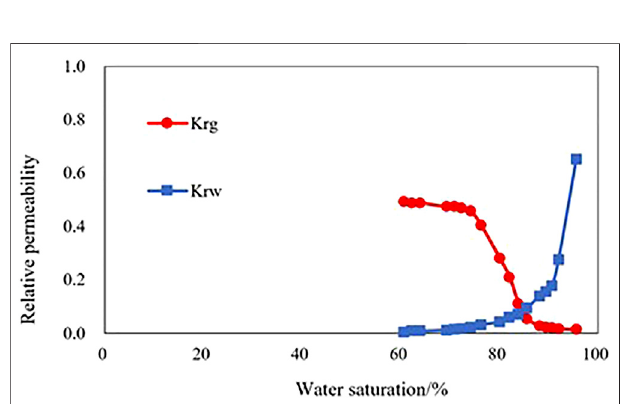
FIGURE 1 | Relationship between core permeability and overburden pressure.